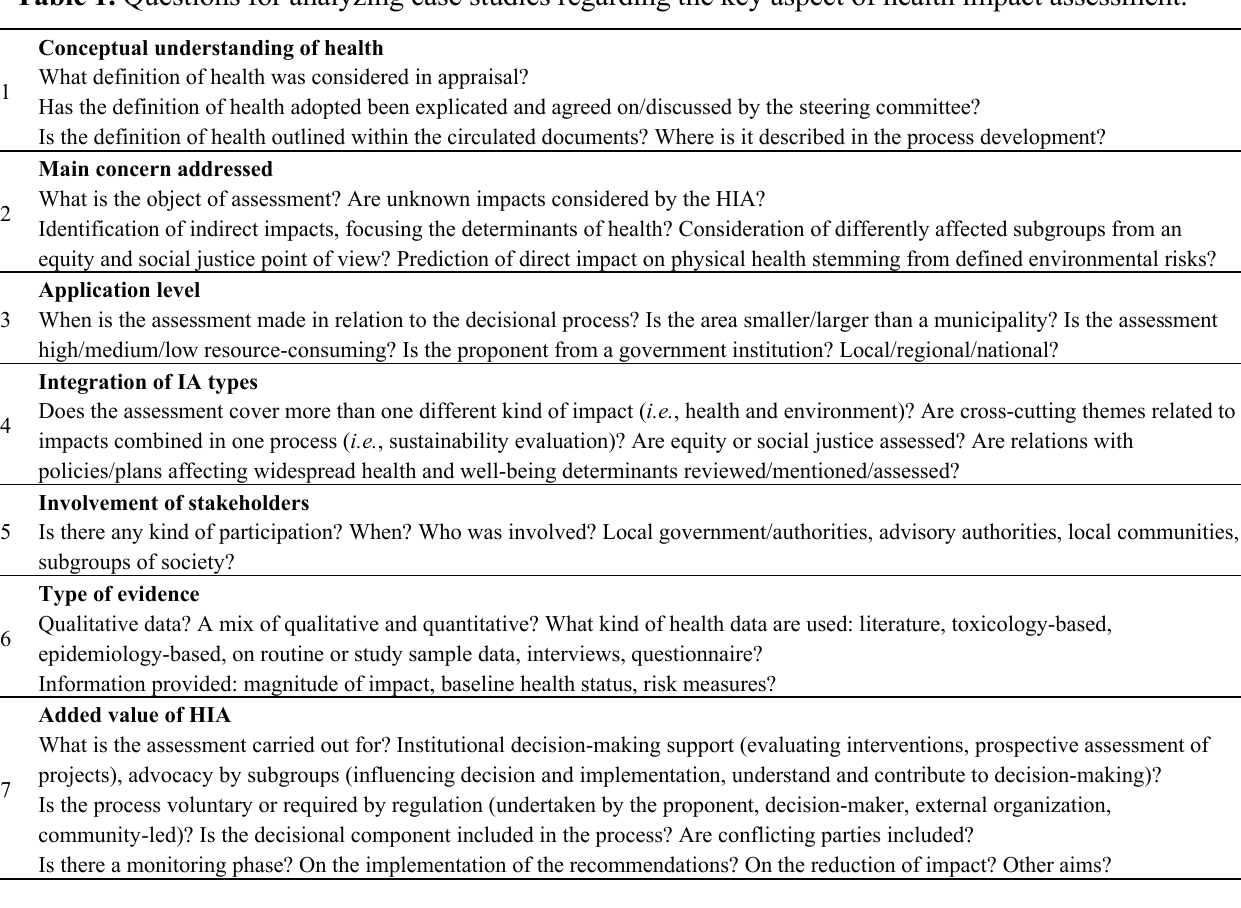
Table 1. Questions for analyzing case studies regarding the key aspect of health impact